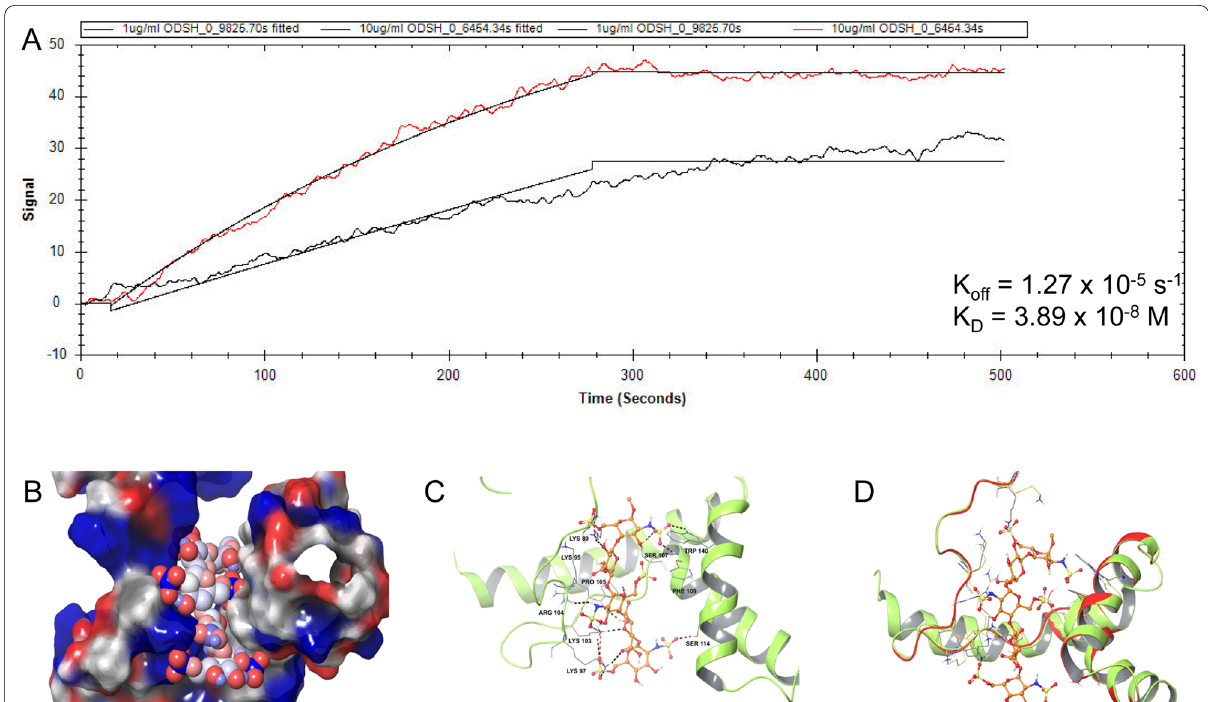
Fig. 7 ODSH binds to HMGB1 and induces conformational changes on HMGB1. The localized surface plasmon resonance (LSPR) binding efficiency of ODSH to HMGB1 was determined by applying ODSH at 1 and 10 µg/mL and measuring its ability to bind to carboxyl sensor chips coated with recombinant HMGB1. A The representative kinetic binding curves demonstrating the ability of ODSH to associate and then dissociate off of HMGB1. The kinetic binding curves were then used to compute the bind efficiency (K D ) for ODSH to HMGB1. Next, induced fit docking experiment was conducted to determine the interactions of ODSH with the B-Box domain of HMGB1 B Surface representation of HMGB1 with ODSH bound to the B-Box domain wherein the blue region represents the concentration of negatively charged, red for positively charged and grey for neutral amino acid residues. ODSH is represented in CPK form with the spheres following the same color pattern as the surface of protein. C The representative 3D docking pose of ODSH bound to HMGB1 B-Box domain. D Superimposition of native, energy minimized HMGB1 (red ribbons) and ODSH docked to HMGB1 (green ribbons). C and D ODSH was represented as ball and stick model whereas the amino acids are shown as thin tubes with atom colors shown as orange for carbons of ODSH, red for oxygen, blue for nitrogen, yellow for sulfur, and grey for carbons belonging to the amino acid residues of ODSH bound HMGB1 and yellow for carbons belonging to the amino acids of native HMGB1. Dashed black lines represent hydrogen bonds and dashed red lines represent ionic interactions between ODSH and